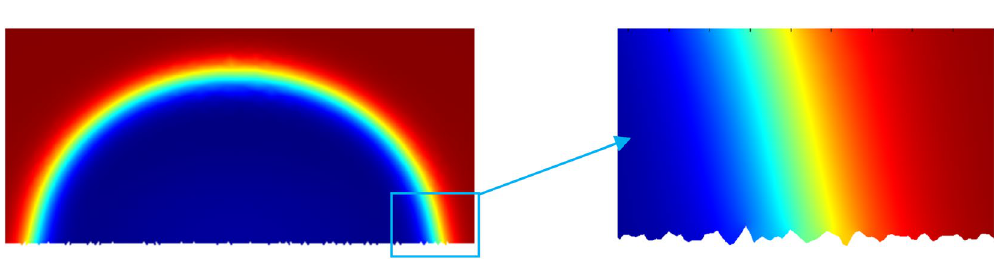
Figure 12. A close-up view of water-coal